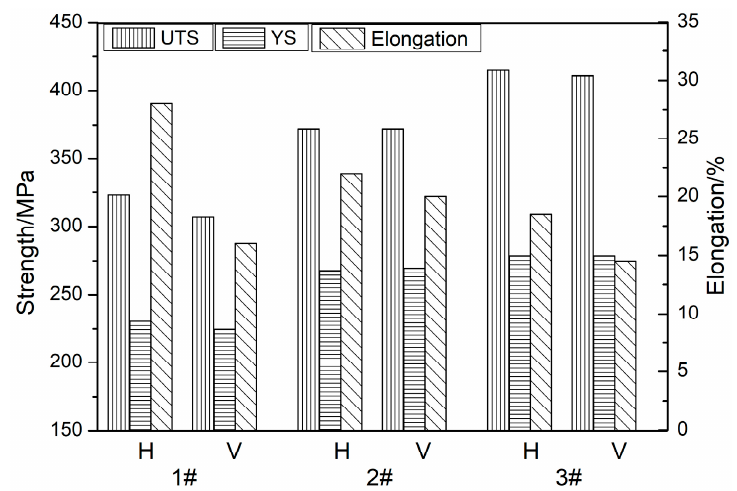
Figure 7. Mechanical properties of the deposits. 1#: Al-Mg alloy deposits; 2#: Al-Mg-0.3Sc alloy deposits; and 3#: Al-Mg-0.3Sc alloy deposits after heating at 350 °C for 1 h. UTS = ultimate tensile strength; YS = yield strength.